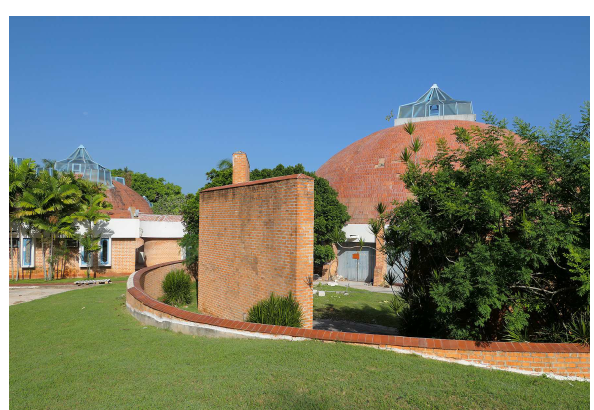
Figure 5. Plastic Art School